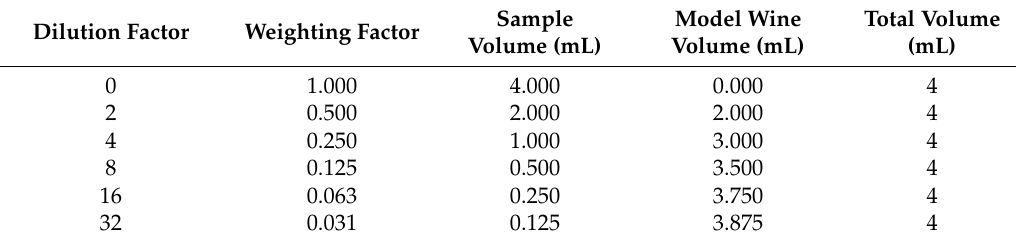
Table 1. Dilution and weighting factors of successive wine sample dilutions used in headspace solid aroma dilution